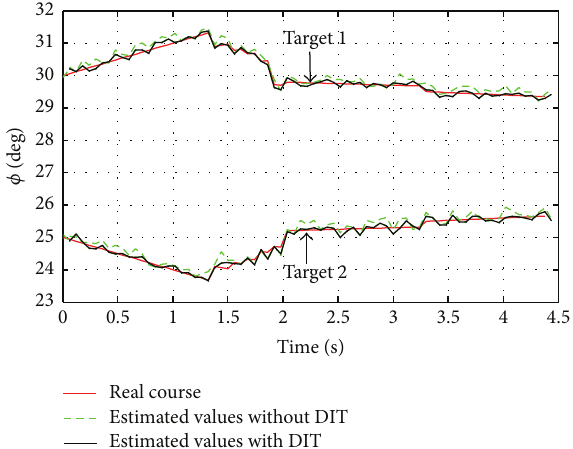
Figure 7: Estimated Doppler frequency RMSEs of T-DIT method.